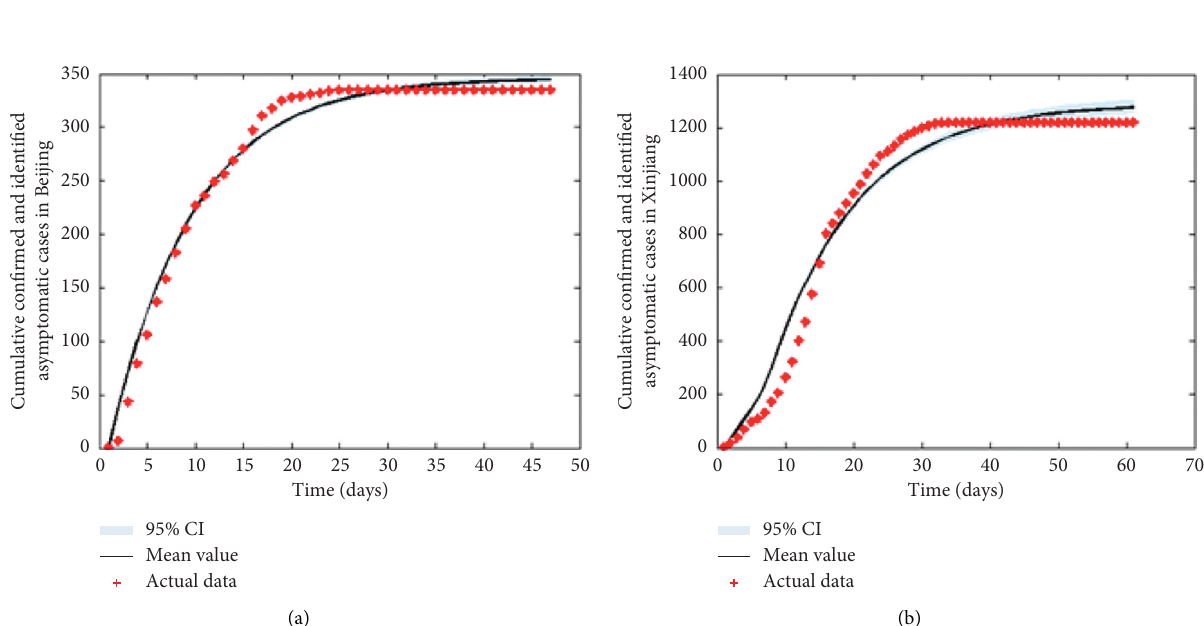
Figure 2: Fitting results of the estimated cumulative number of confirmed and identified asymptomatic COVID-19 cases with its actual reported numbers in Beijing and